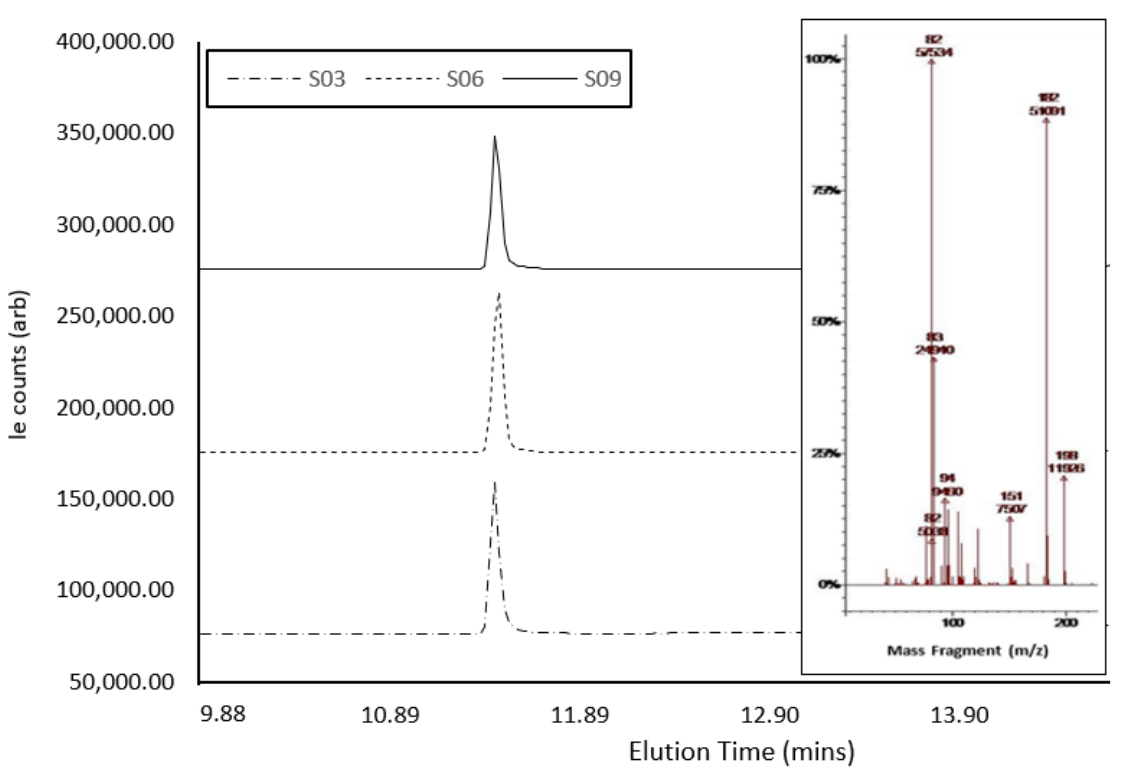
Figure 4. GCMS spectra of cocaine samples S3, S6, and S9, showing elution times and peak size, with the MS-spectra inlay showing abundant molecular ions at m / z 182 and 82.